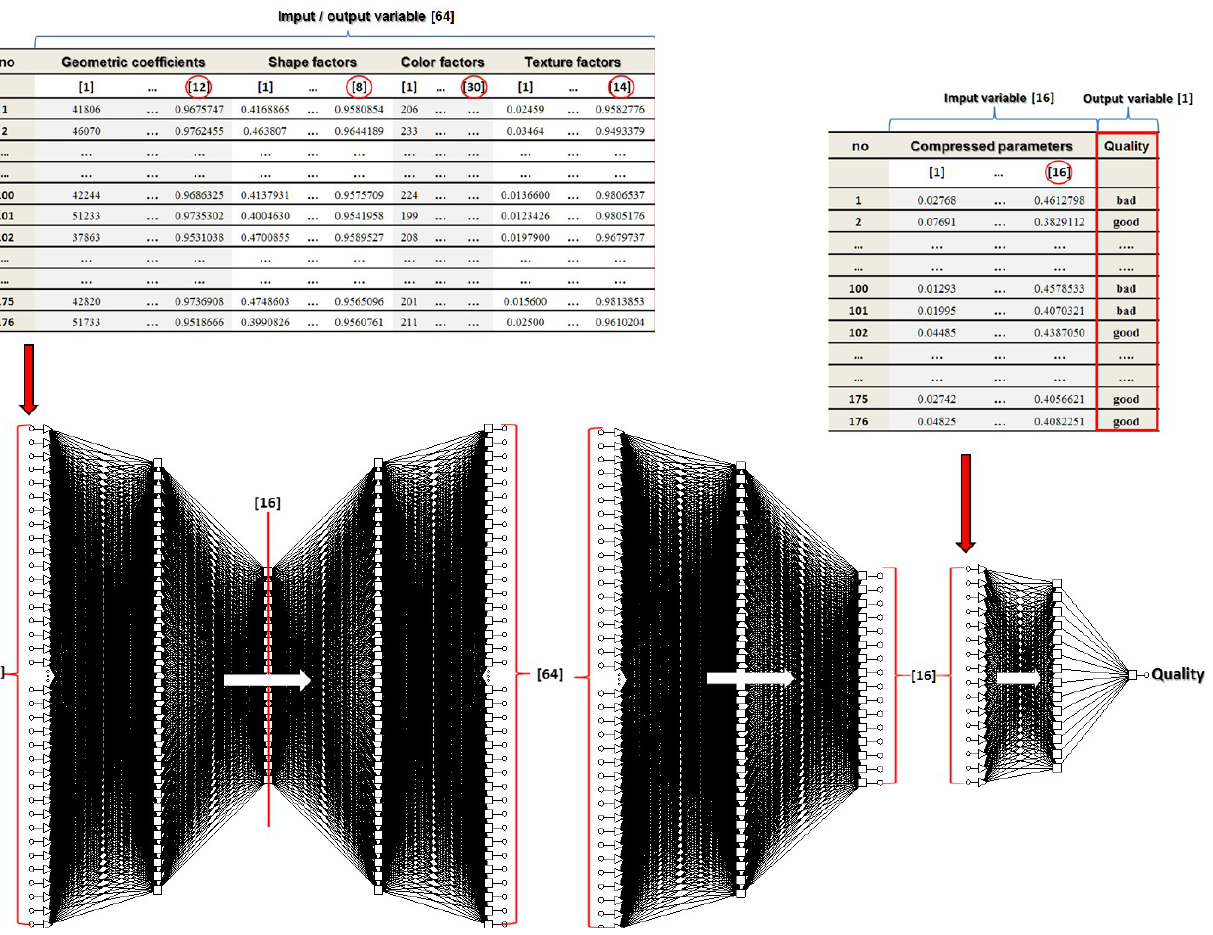
Figure 7. Structure of the simulation procedure. Figure 8. Structure of the simulation